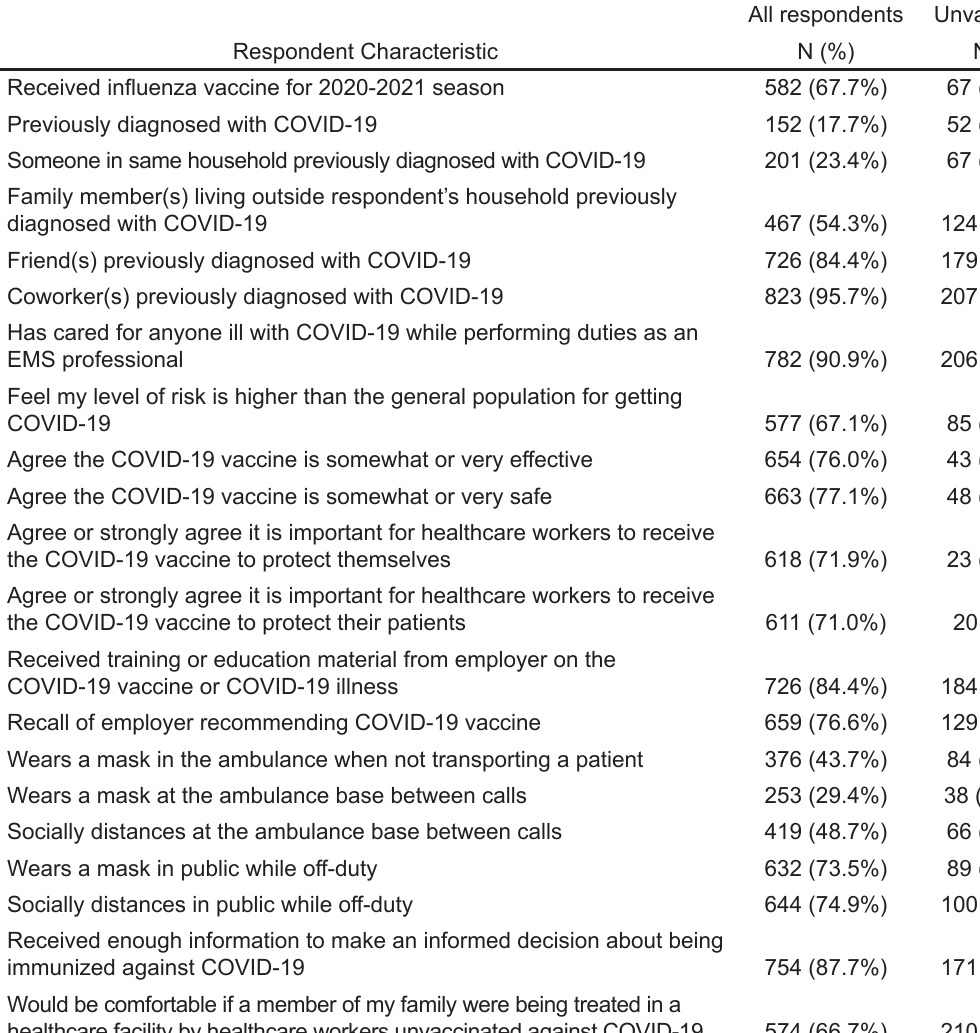
Table 2. Differences between vaccinated and unvaccinated